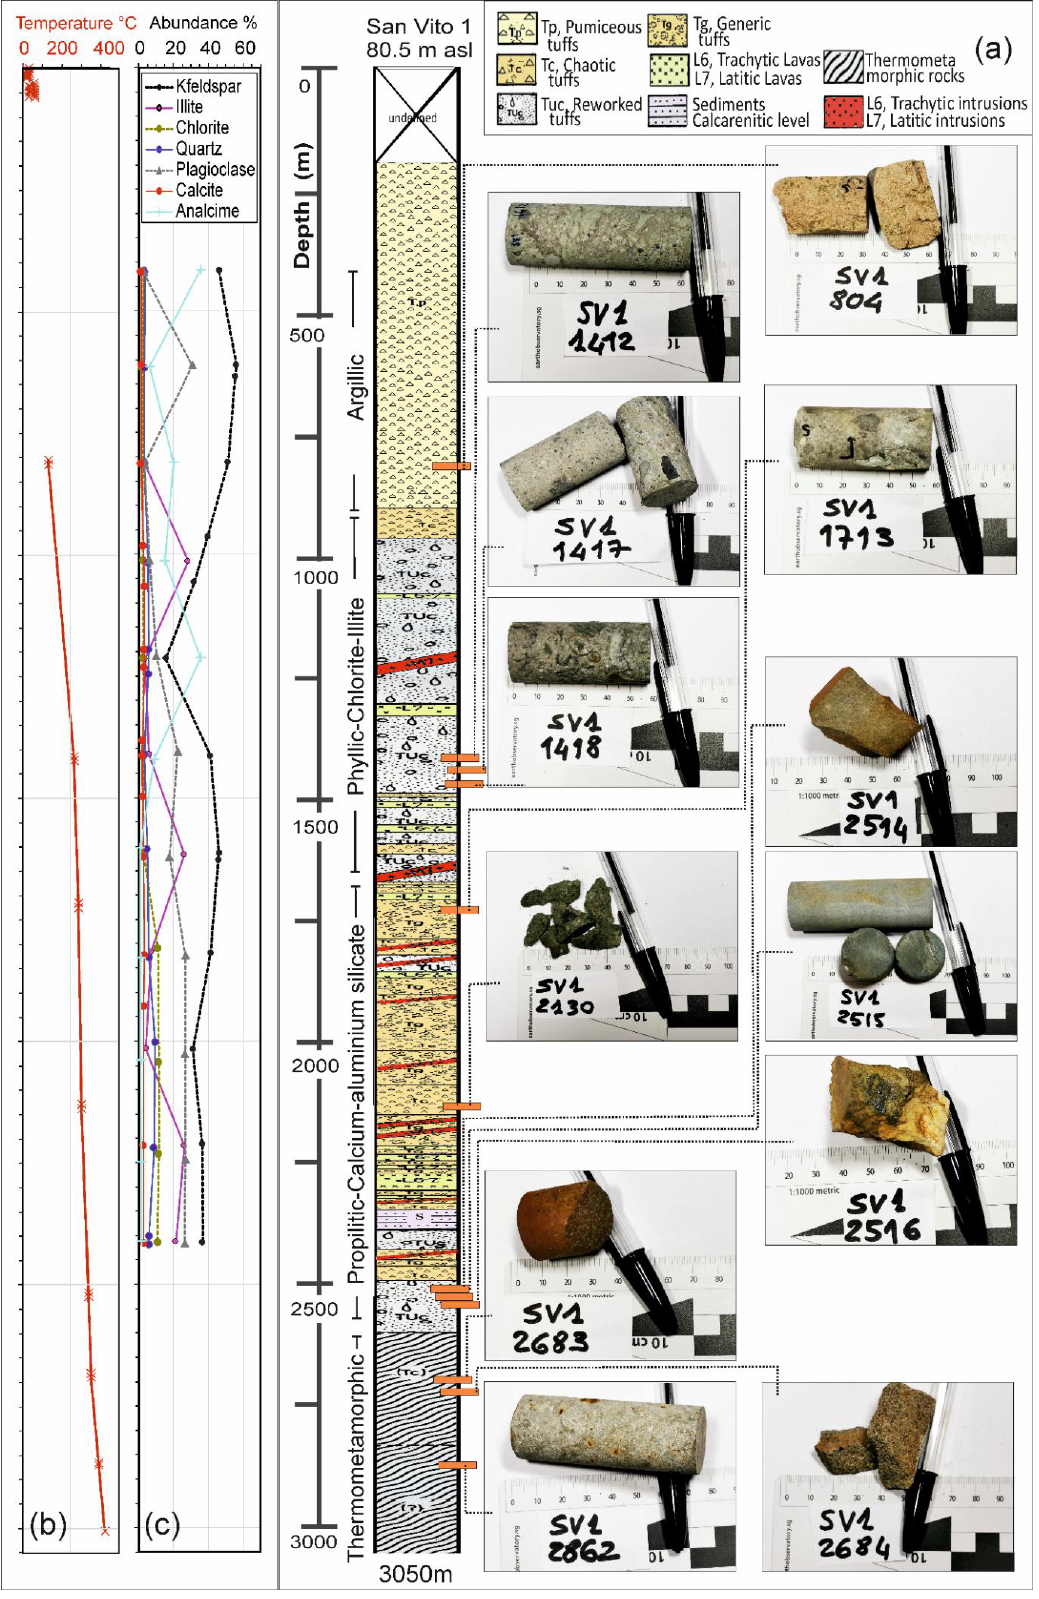
Figure 2. ( a ) Downhole San Vito 1 stratigraphy with the depth location and photo of cores, alteration facies and distribution of ( b ) temperature and ( c ) mineral abundance. Data source: Piochi et al. [5] for the lithology, De Vivo et al. [8] for the